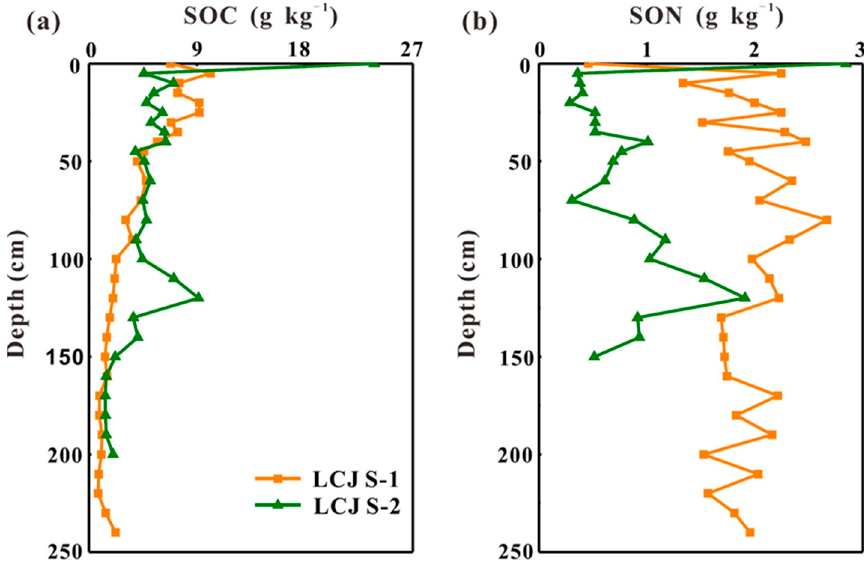
Figure 2. Vertical distribution of SOC ( a ) and SON ( b ) in soil profiles. (SON contents of soil samples below 150 cm in soil profile LCJ S-2 were lower than the instrument detection limit).